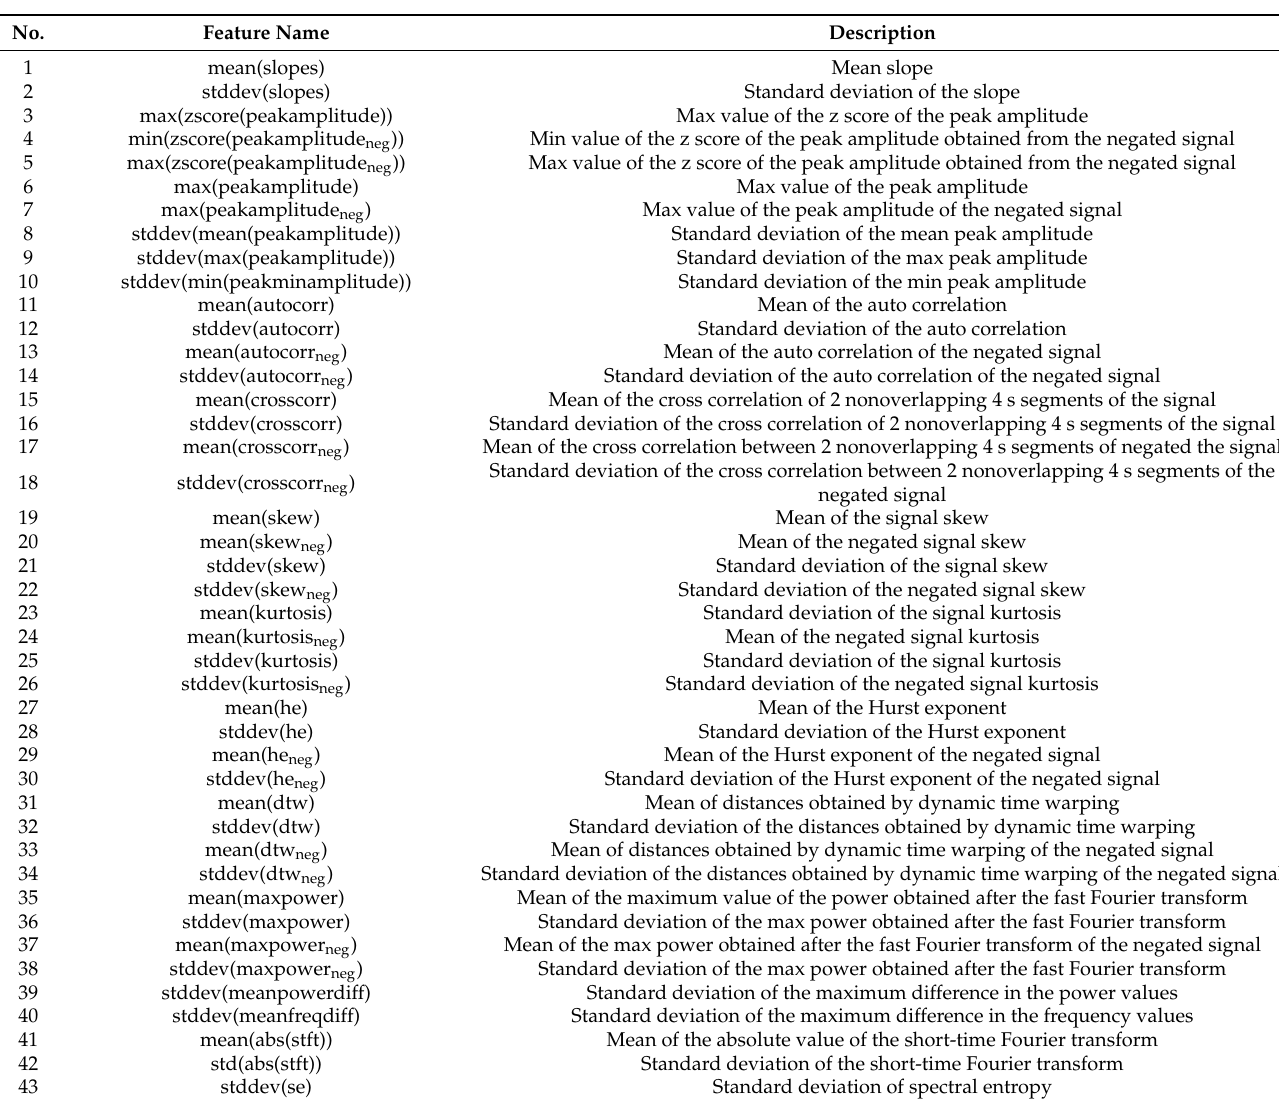
Table 1. List of the 43 features selected using scipy’s KBest algorithm in the RF approaches. Features extracted from the negated signals are indicated with the subscript neg. Features 1–34 are time domain features, while features 35–43 are frequency domain features. The fundamental details and pseudocodes for feature extraction can be found in Supplementary Material Sections S2 and